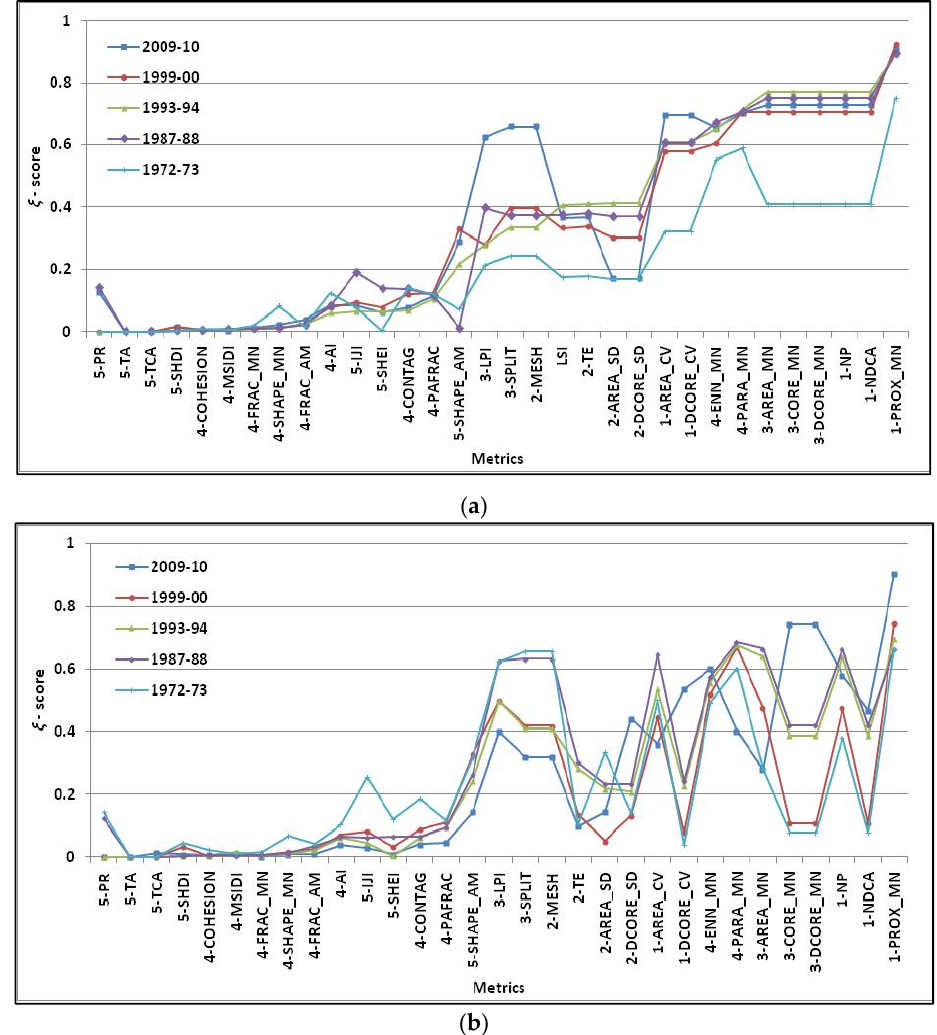
Figure 5. ( a , b ) ξ -scores of landscape metrics ranked in ascending order for the Liverpool Range and Liverpool Plains, respectively. (number before metric indicates cluster number, see Section 4.1). (See Table 1 for details of each metric).